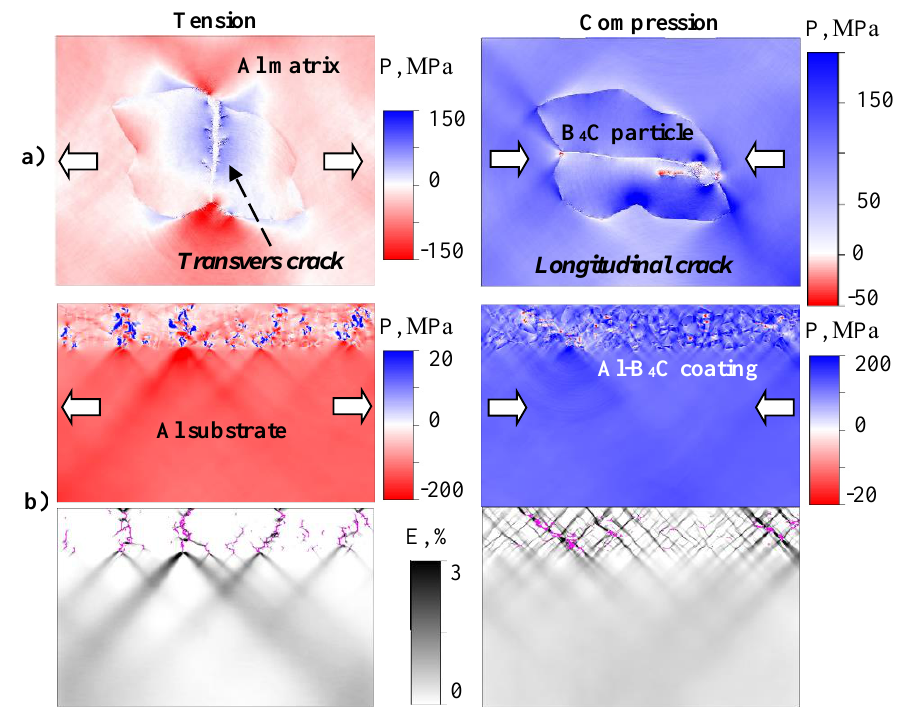
Fig. 3. Crack propagation in single particle (a) and in composite coating (b) under tension and compression of the composite materials. P is the pressure and E is the equivalent plastic strain with the fractured regions marked by magenta